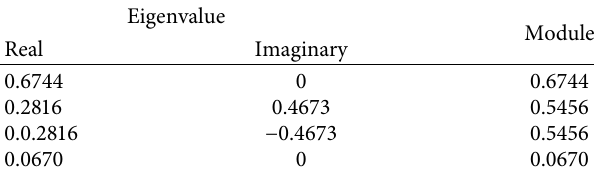
Table 2: Unit root test for core variables.